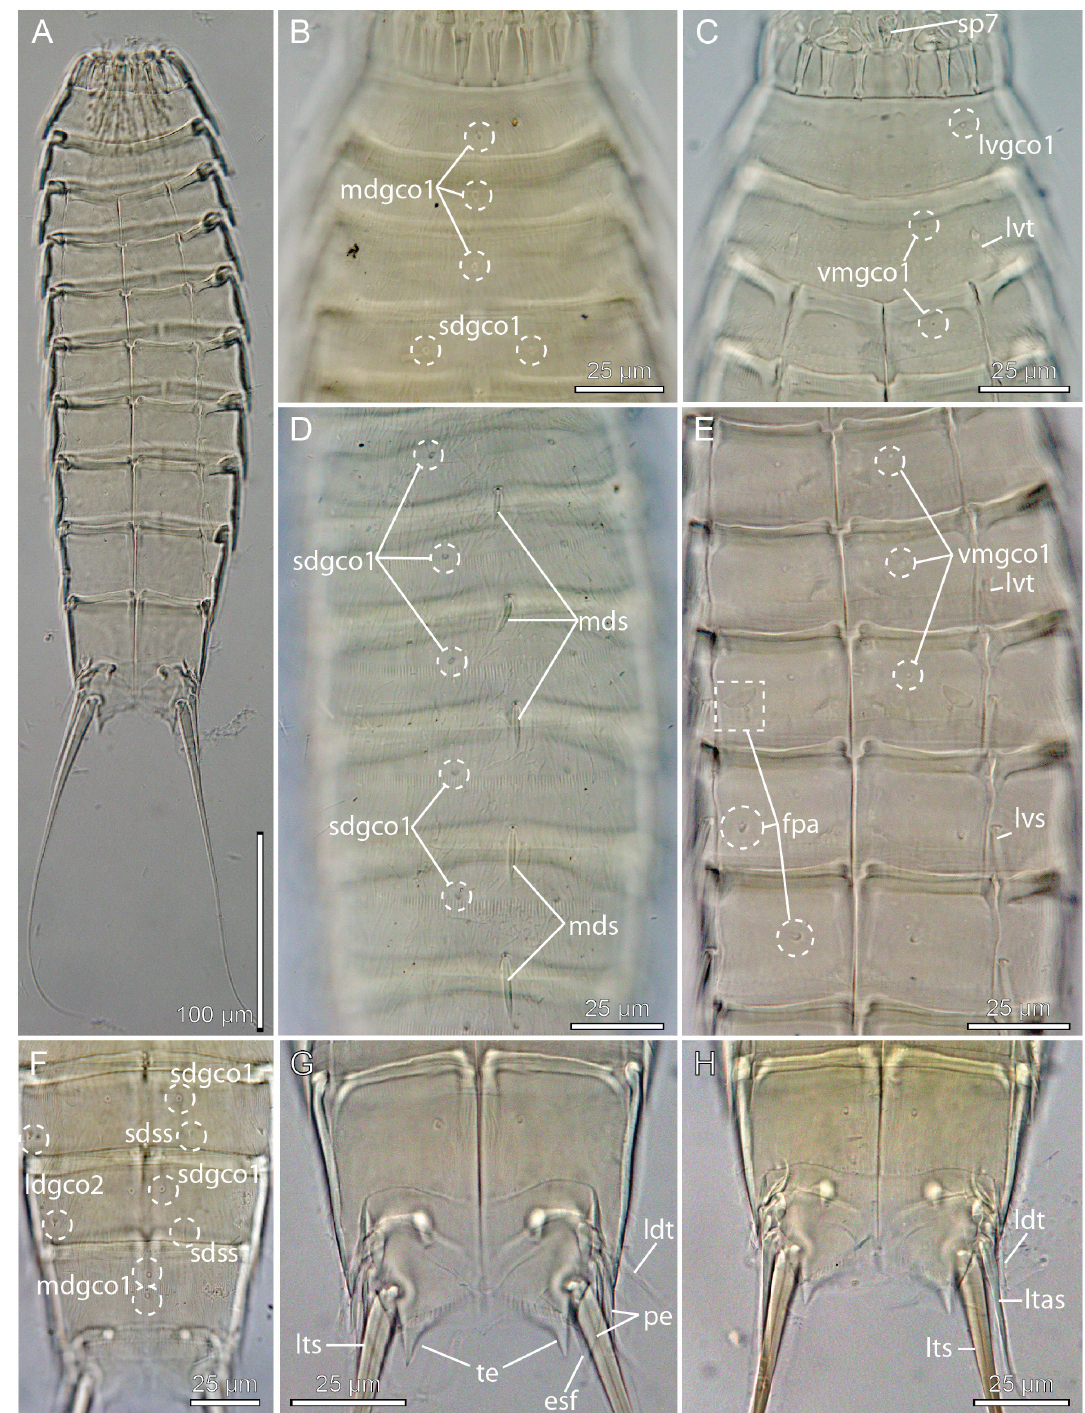
Fig. 7. Light micrographs showing overviews and details of Echinoderes imperforatus Higgins, 1983. A, D–E . Holotype, ♀ (USNM-69972). B, F, H . Paratype, ♀ (USNM-69974). C, G . Paratype, ♂ (USNM-69975). A . Ventral overview. B . Segments 1 to 3, dorsal view. C . Segments 1 to 3, ventral view. D . Segments 4 to 8, dorsal view. E . Segments 4 to 8, ventral view, showing female sexual dimorphism. F . Segments 8 to 10, dorsal view. G . Segments 10 to 11, ventral view, showing male sexual dimorphism. H . Segments 10 to 11, ventral view, showing female sexual